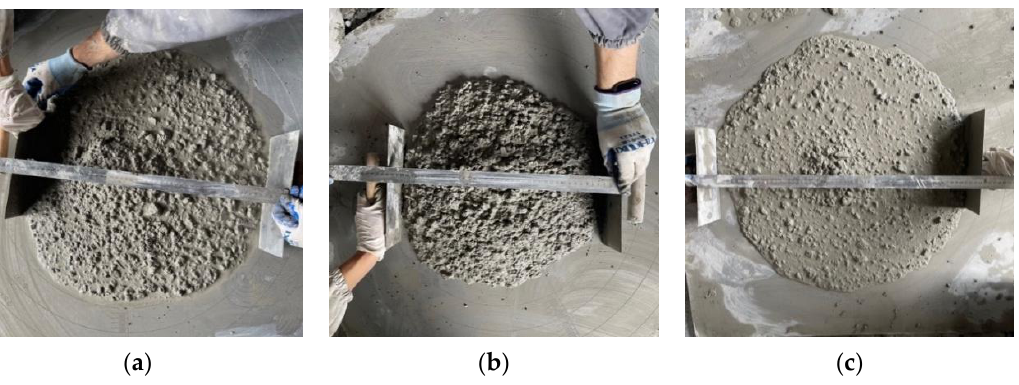
Figure 9. Appearance of concrete mixture of C30 strength grade. ( a ) C30DMS. ( b ) C30WMS. ( c ) C30M-S.